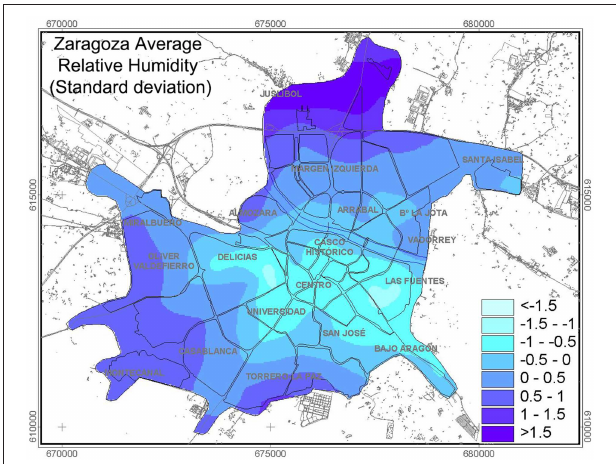
FIGURE 5 | Zaragoza average relative humidity map.